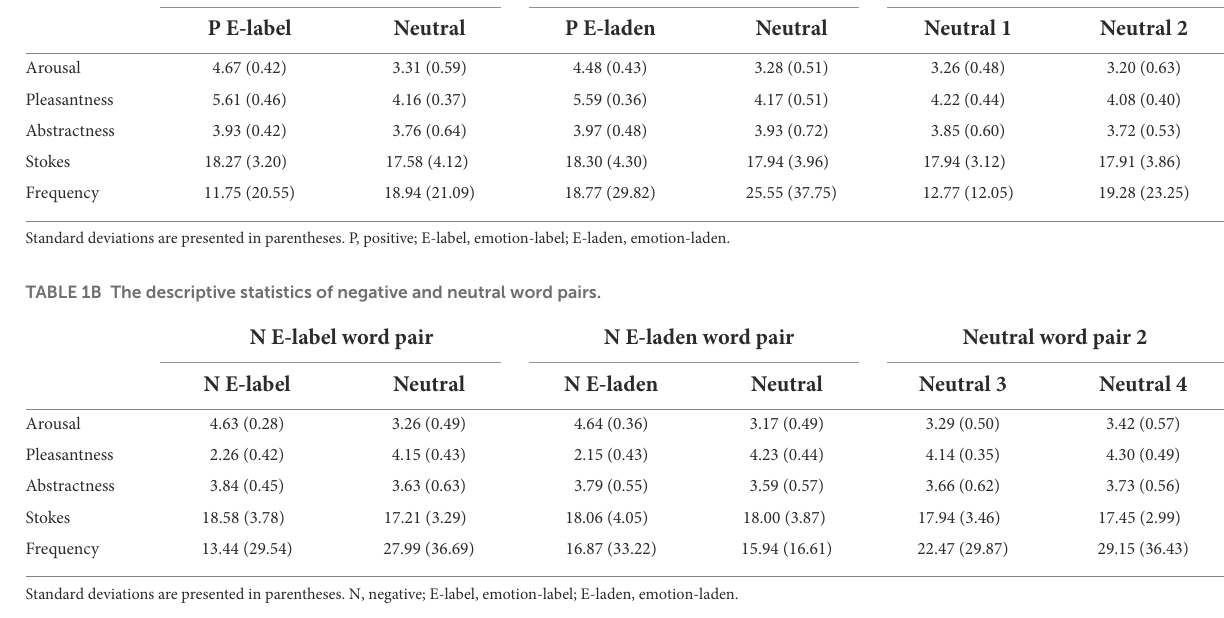
TABLE 1A The descriptive statistics of positive and neutral word pairs. P E-label word pair